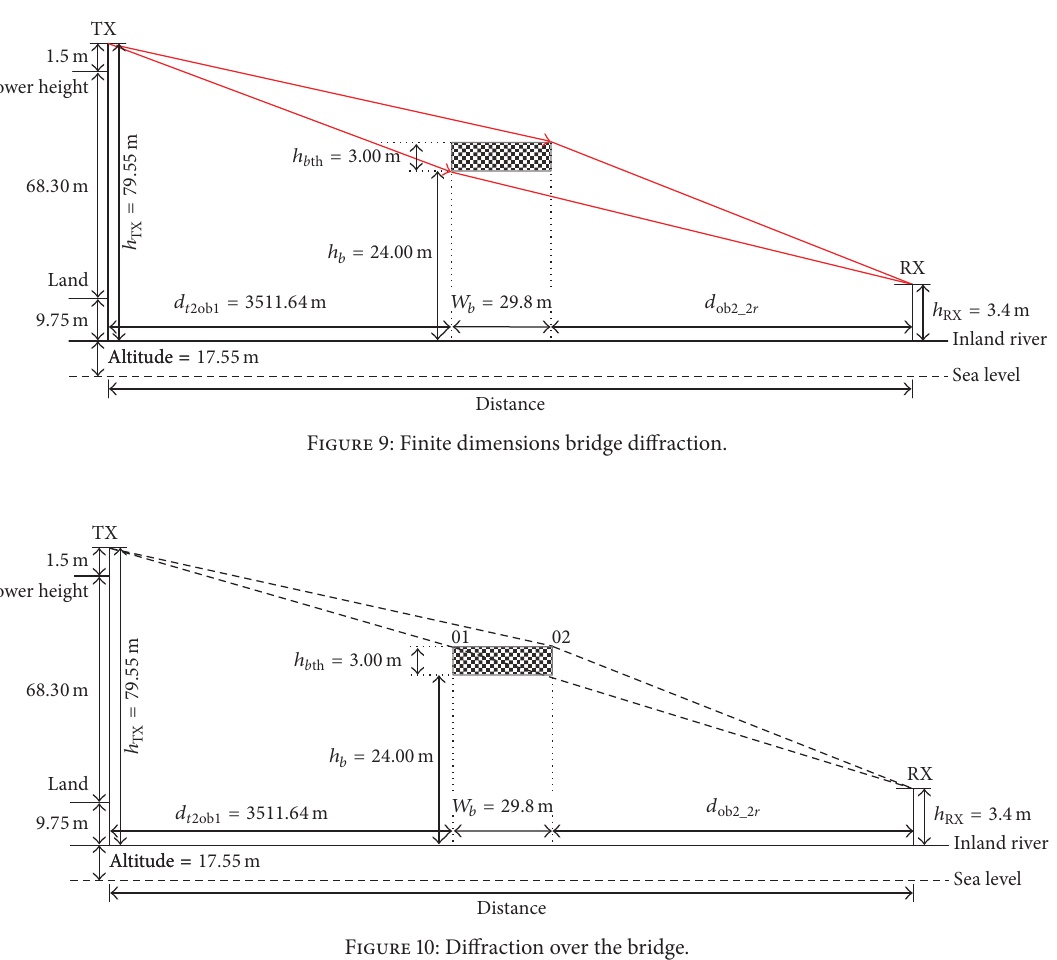
Figure 10: Diffraction over the